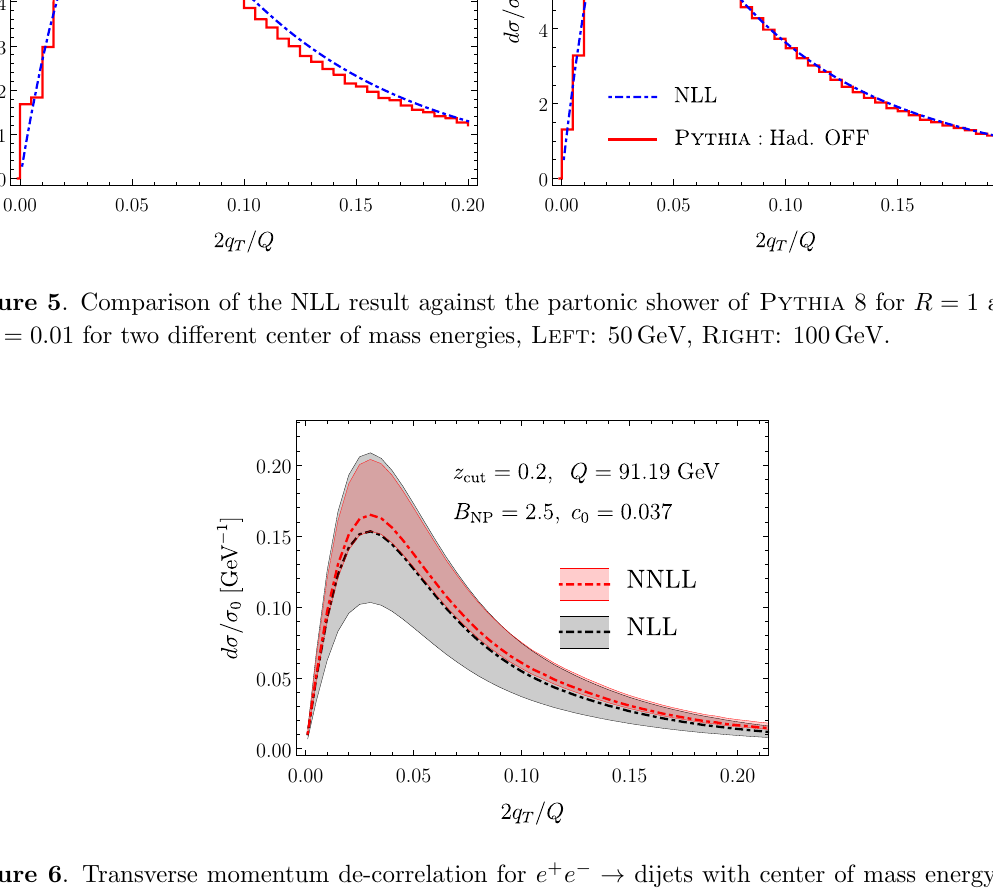
dijets with center of mass energy at − →